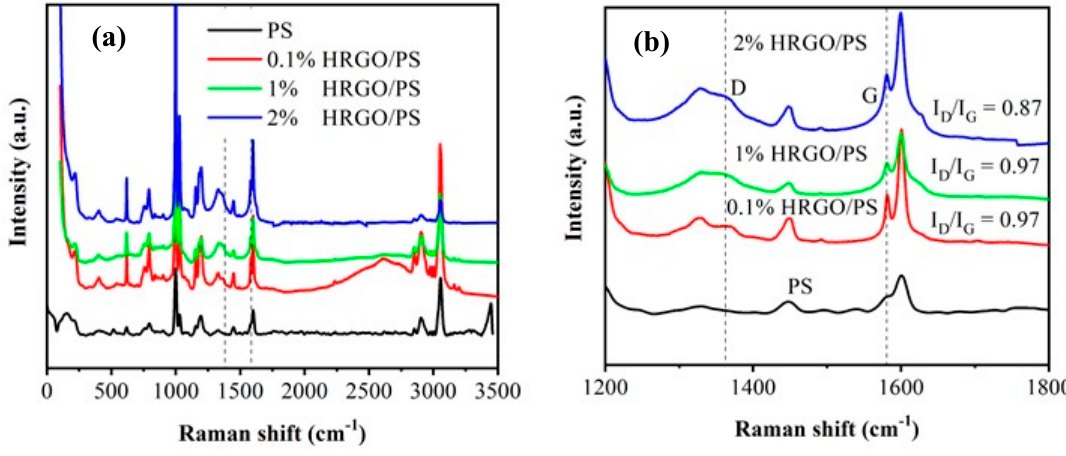
Figure 2. ( a ) and ( b ) Raman spectra of 0.1% HRGO / PS, 1% HRGO / PS, and 2% HRGO / PS nanocomposites indicating the D and G bands.